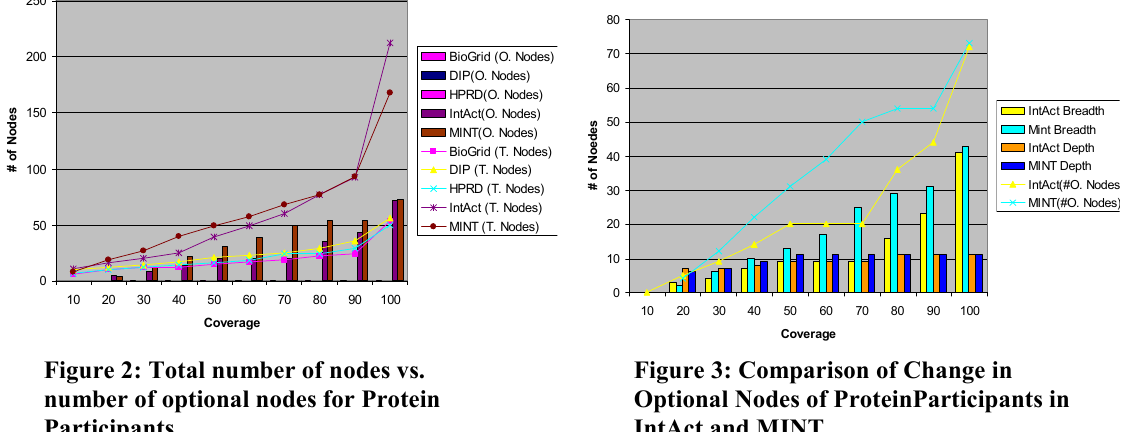
Figure 2: Total number of nodes vs. number of optional nodes for Protein Participants